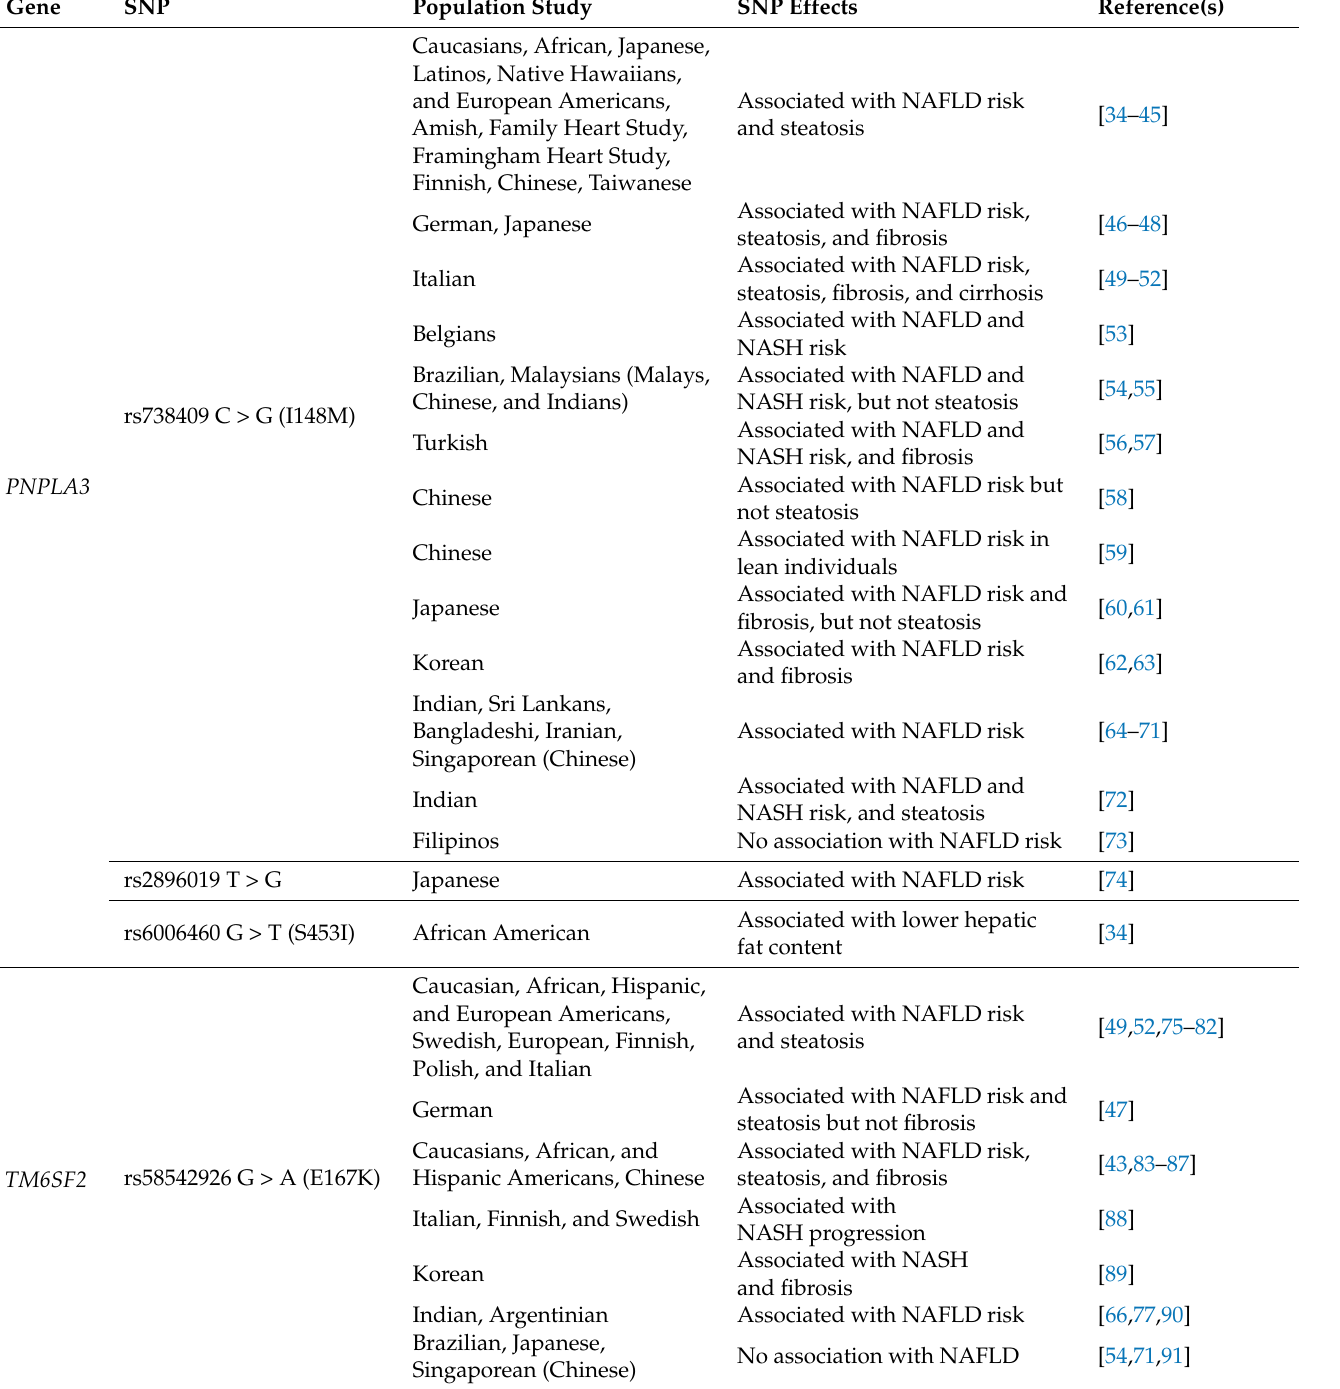
Table 1. Summary of the commonly reported single nucleotide polymorphism (SNP) associated with